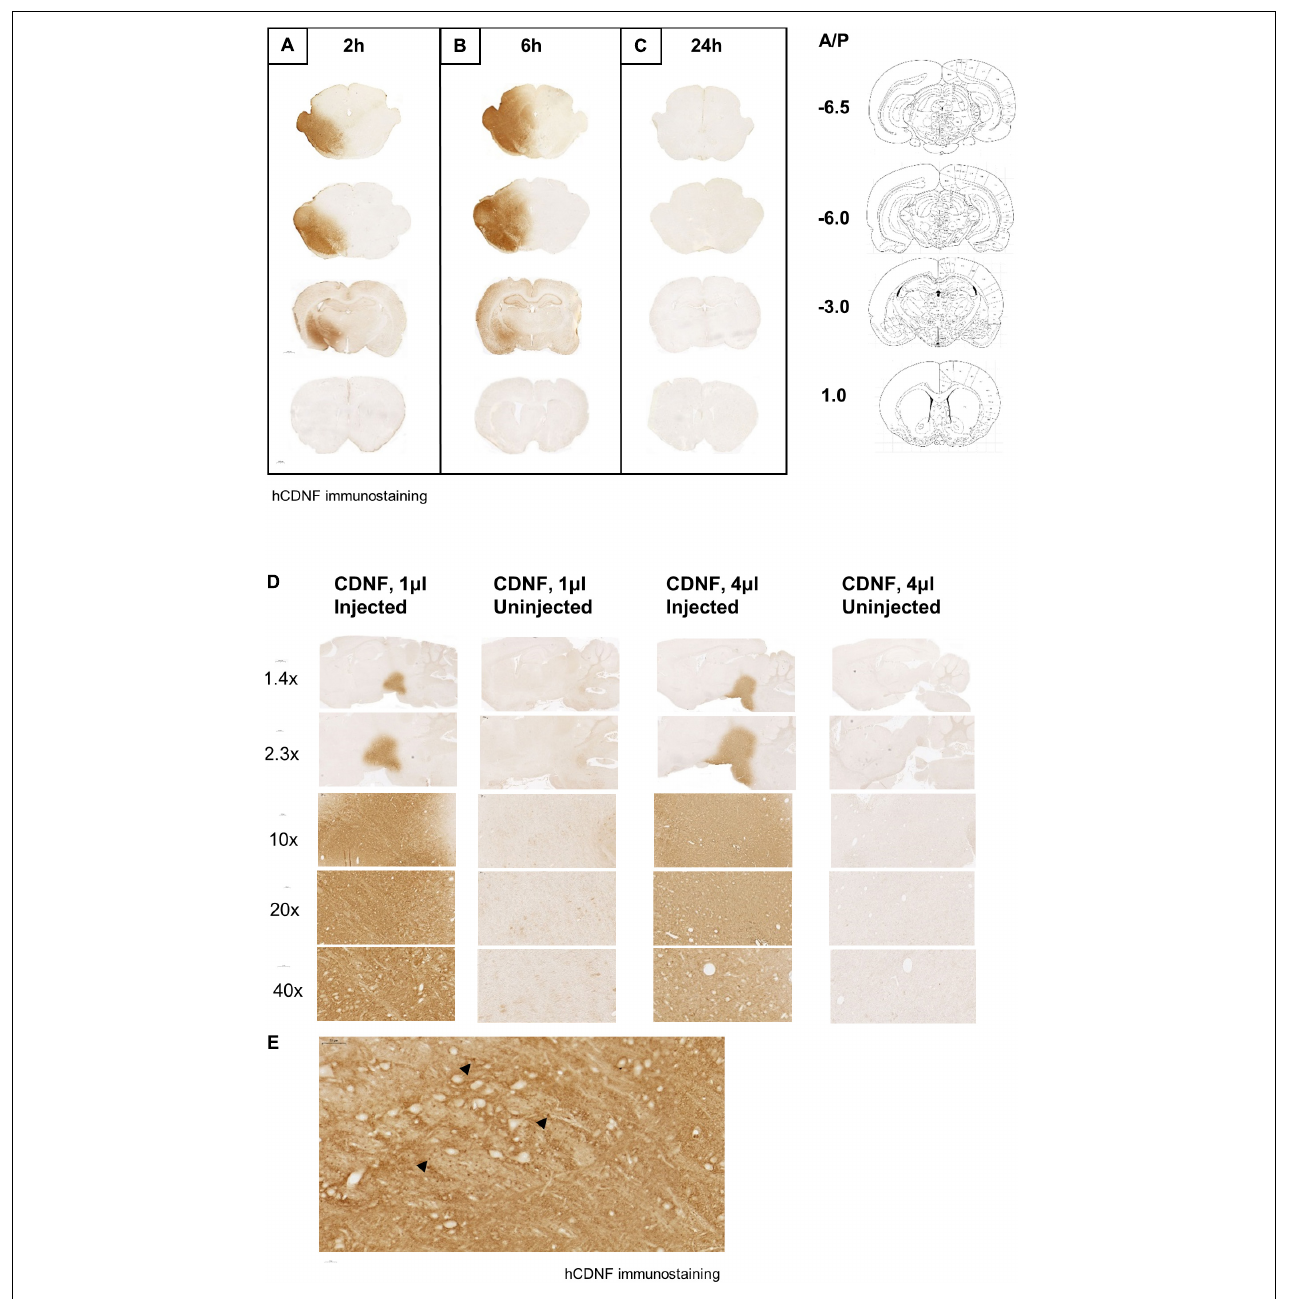
FIGURE 2 | Diffusion of human CDNF after injection to the SN in naive rat brain at different time points and volumes. CDNF (3 µ g in 4 µ l) was injected to the SN of rats and perfused (A) 2, (B) 6, or (C) 24 h later. Human CDNF (hCDNF) immunostaining of a representative posterior, nigral, thalamic, and striatal section for each time point. N = 2/time point. Diffusion of human CDNF (3 µ g) when injected into the SN in the volume of 1 or 4 µ l. Rats were perfused 2 h after the injection. (D) Increasing magnification of CDNF injected side versus the uninjected side of the injected area. (E) 40 × maginification of injected area. Black arrowheads indicate dark brown puncta staining of